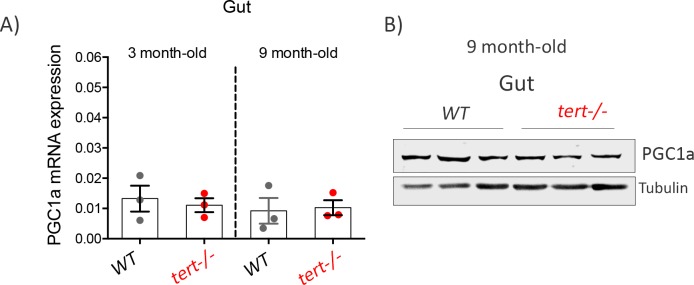
PGC1a expression is not altered in tert-/- mutants compared to WT.No differences are detected in PGC1a expression between tert-/- and WT gut at 3 and 9 months. (A) RT-qPCR and (B) representative Western blot analysis of PGC1a in gut of 3- and 9-month-old tert-/- or WT siblings (N = 3 fish). The graphs are representing mean ± SEM mRNA fold increase after normalisation by rpl13a gene expression levels.Figure 3—figure supplement 1—source data 1.Real-time qPCR data of PGC1a, as plotted in Figure 3—figure supplement 1.